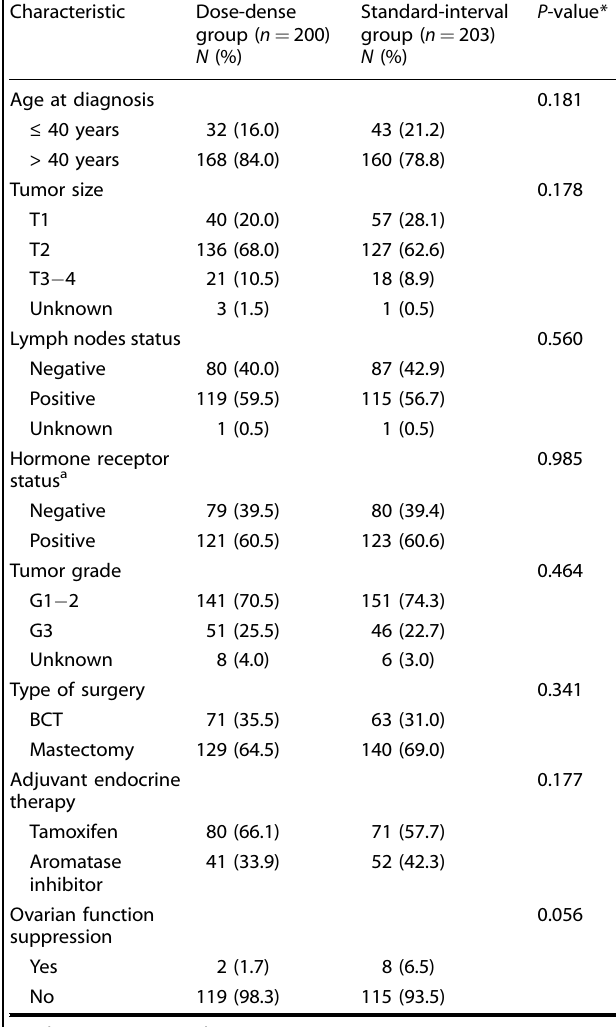
Table 1. Baseline clinicopathologic characteristics of HER2-positive breast cancer patients with exposure to